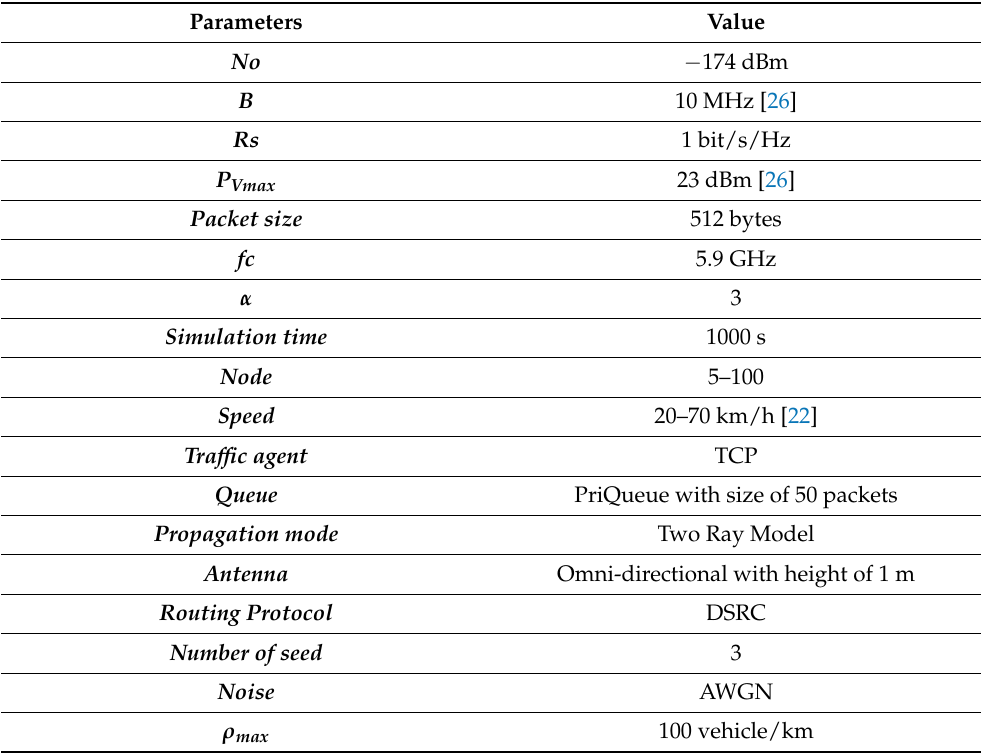
Table 2. Simulation